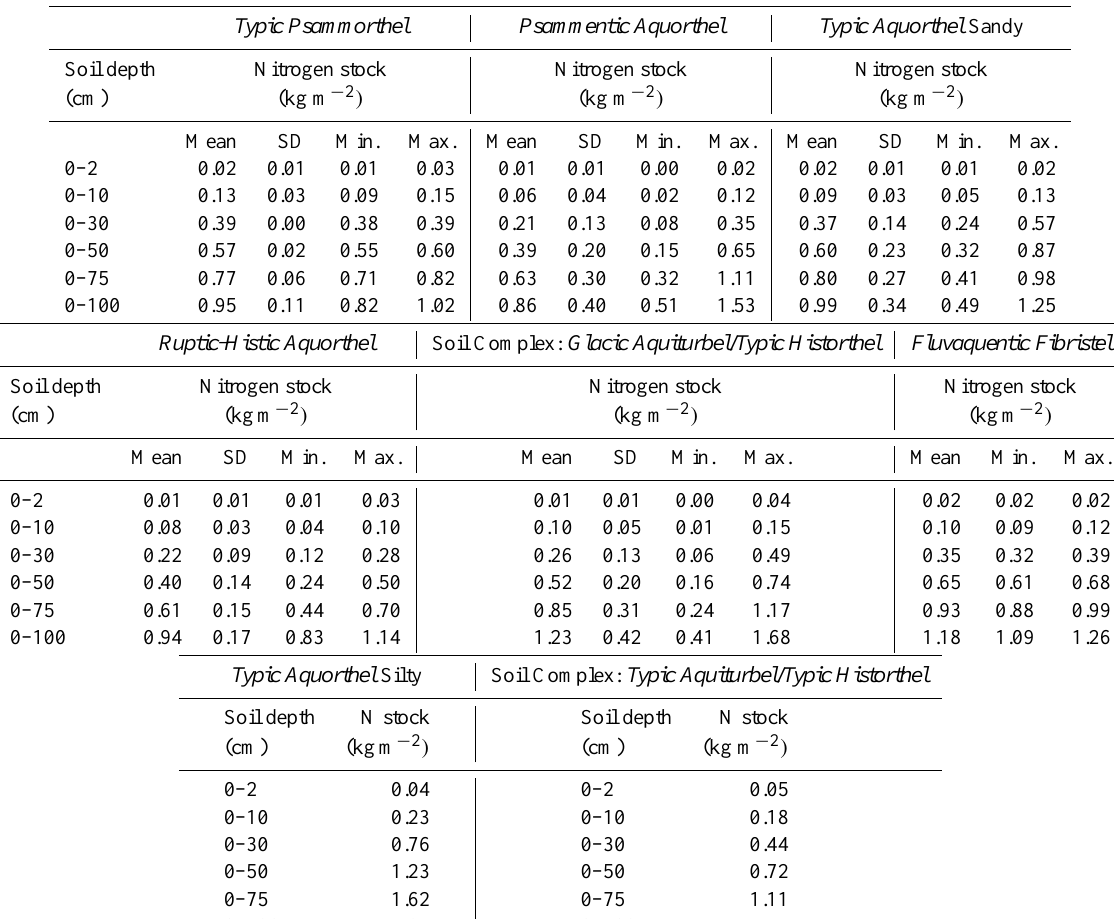
Table 6. The nitrogen stocks of the soil subgroups of Samoylov Island. The results are expressed in kgm − 2 with the mean values and the respective standard deviations as well as the minima and maxima.